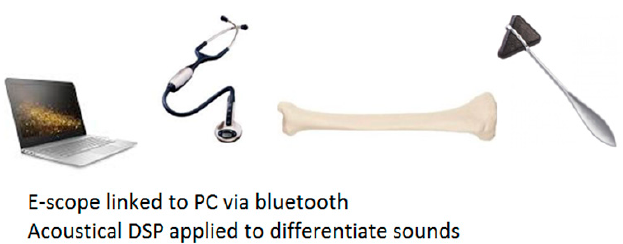
Figure 1. An illustration of a practical method for an osteoporosis screening testing.